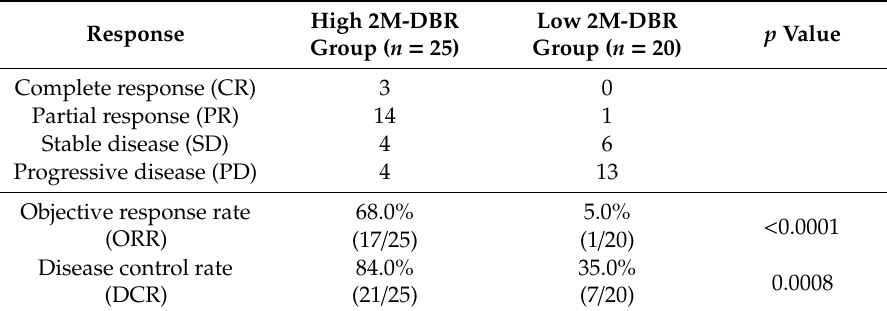
Figure 1. Receiver operating characteristic (ROC) curve analyses of the relative dose intensity at 60 days (2M-RDI) and the delivered dose intensity / body surface area ratio at 60 days (2M-DBR) to predict the objective response to lenvatinib at 8–12 weeks. ( a ) The area under the ROC (AUROC) of 2M-RDI was 0.7778 at an optimal cut-o ff value of 66.1% (sensitivity, 88.9%; specificity, 66.7%). ( b ) The AUROC of 2M-DBR was 0.8004 at an optimal cut-o ff value of 238.9 (sensitivity, 94.4%; specificity, 70.4%), which was higher than that of 2M-RDI. Table 3. Response to lenvatinib according to the 2M-DBR levels.